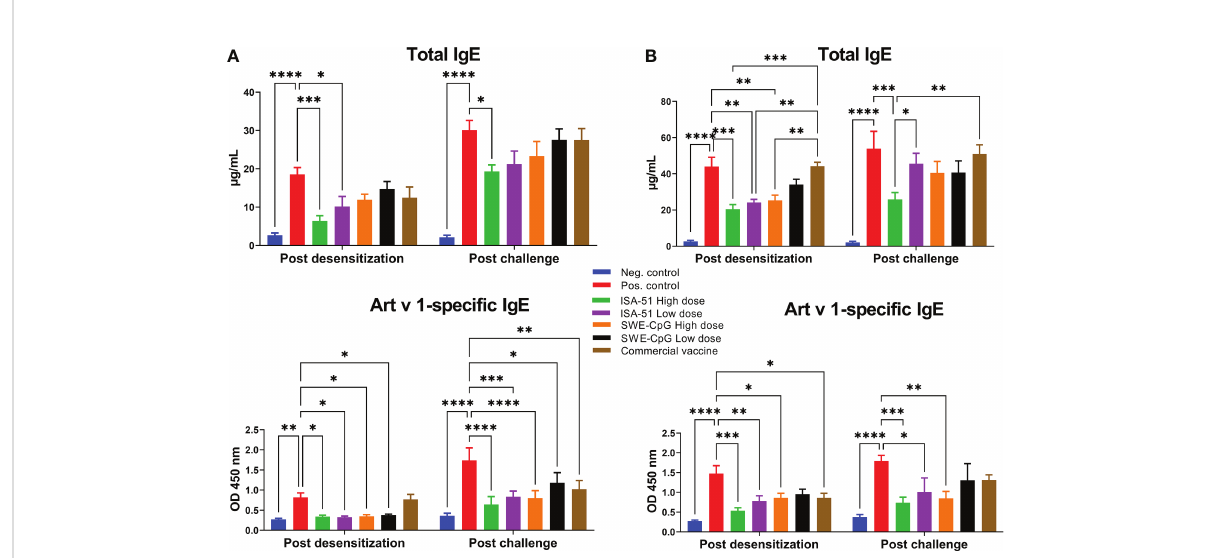
FIGURE 2 Reduction levels of total and Art v 1-speci fi c IgE antibodies in Artemisia vulgaris -sensitized BALB/c mice after pre-seasonal (A) and co-seasonal (B) ASIT using different vaccine formulations. ASIT was performed with various vaccine formulations containing increasing high and low dose allergen (recombinant major Artemisia vulgaris pollen Art v 1 protein) and adjuvants such as ISA-51 and SWE-CpG. A commercial vaccine group was also included for comparison, comprising Artemisia vulgaris pollen extract formulated with aluminum hydroxide adjuvant. Challenge of mice after pre- and co-seasonal ASIT was performed by intranasal administration and nebulization of Artemisia vulgaris pollen extract. The concentration of total IgE antibodies is expressed as µg/mL. Art v 1-speci fi c IgE antibody levels are shown as optical density values at 450 nm. Differences in IgE antibody levels between animal groups were assessed using Tukey ’ s multiple comparisons test. A P<0.05 value was considered a signi fi cant difference. *P <0.05, **P <0.01, ***P <0.001, and ****P